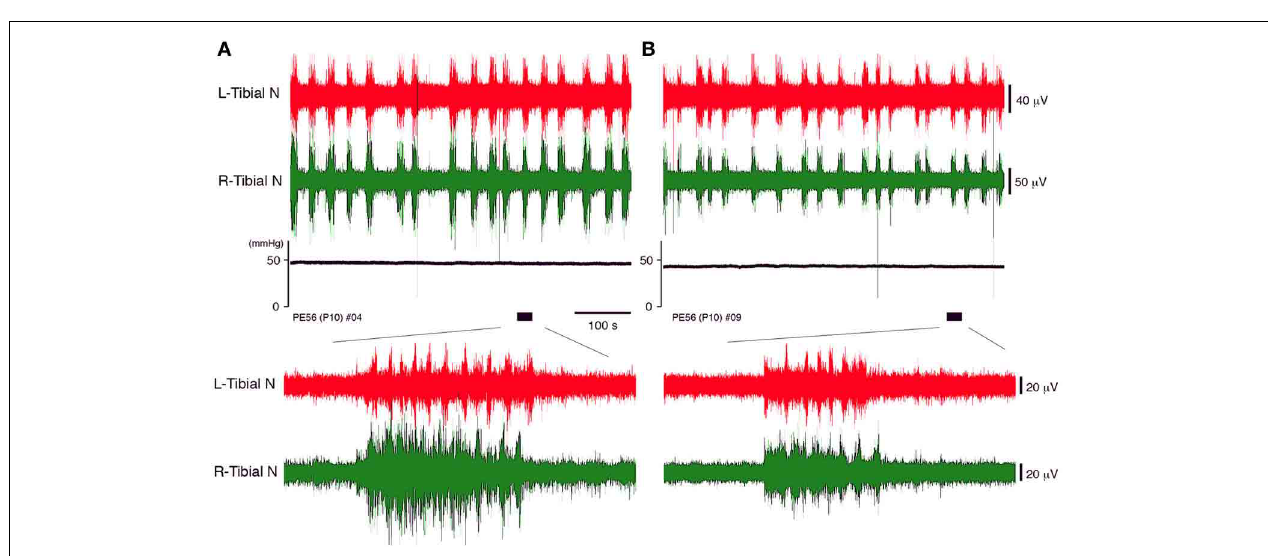
FIGURE 2 | Continued time, the rhythm of the instances of left/right peroneal and phrenic nerve discharge during each discharge episode became more rapid, and small changes of systemic pressure occurred during discharge episodes. (B) Dependence of heart rate, systemic pressure, amplitude of the peripheral motor nerve discharge (PMD), and cycle periods produced outside of phrenic discharge episodes (PHD) on the flow rate tested. All data were obtained from the five preparations. The mean (SE) amplitude of